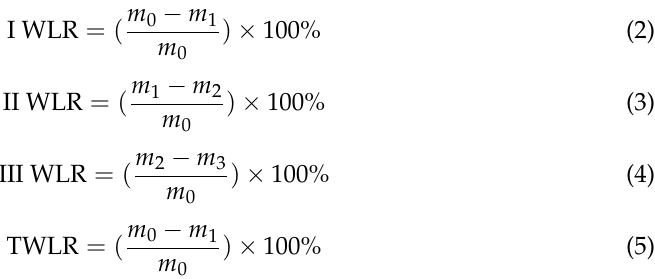
Table 9. Lattice parameter of Fe 2 O 3 and Fe 3 O 4 .